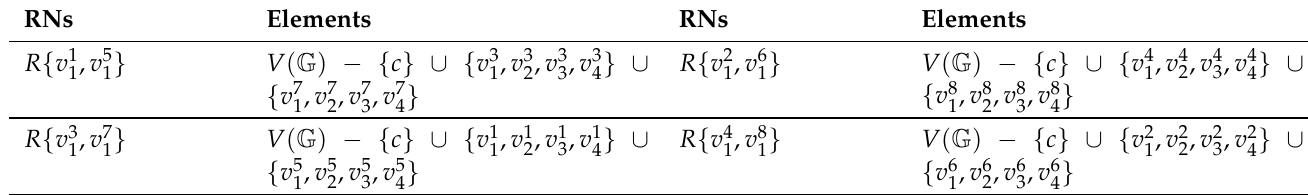
Table 17. RNs ´ R u for 78 ≤ u ≤ 81.